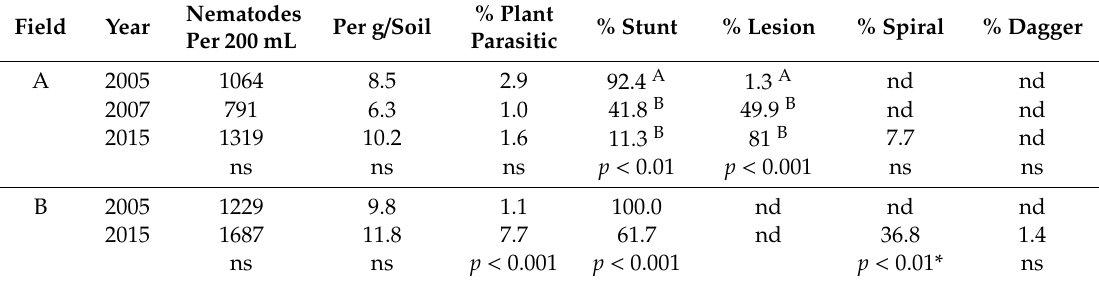
Table 1. Mean nematode counts of total free living nematodes, per g dry weight equivalent of soil and the percentage of plant parasitic from 200 mL soil Whitehead tray recoveries of samples collected in cotton fields A and B in the Namoi valley. The percentage contributions of the stunt ( Merlinius and Tylenchorhynchus spp.), lesion ( Pratylenchus sp.) spiral ( Helicotylenchus sp.) and dagger nematodes to the plant parasitic nematodes within samples and years are given. Similarities in the plant parasitic population are assessed with Wilcoxon rank-sum tests and significantly similar medians are indicated with the same upper case letter.